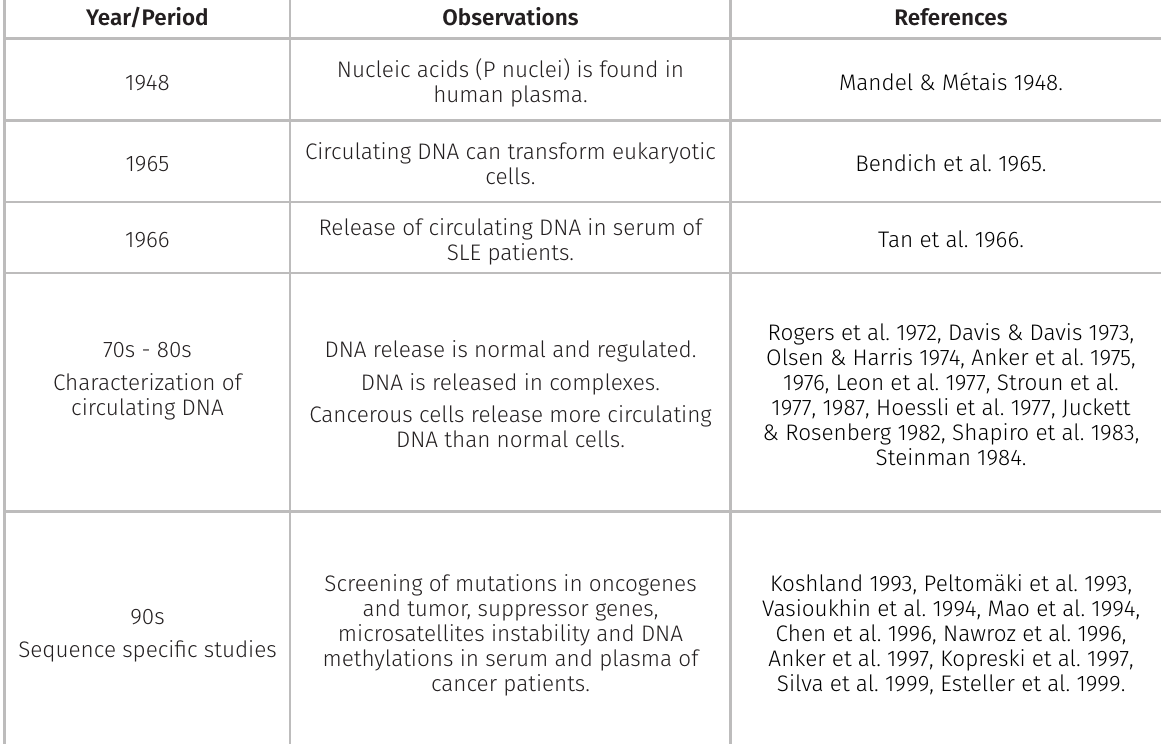
Table I. Landmarks in circulating DNA in the 20 th century. Year/Period